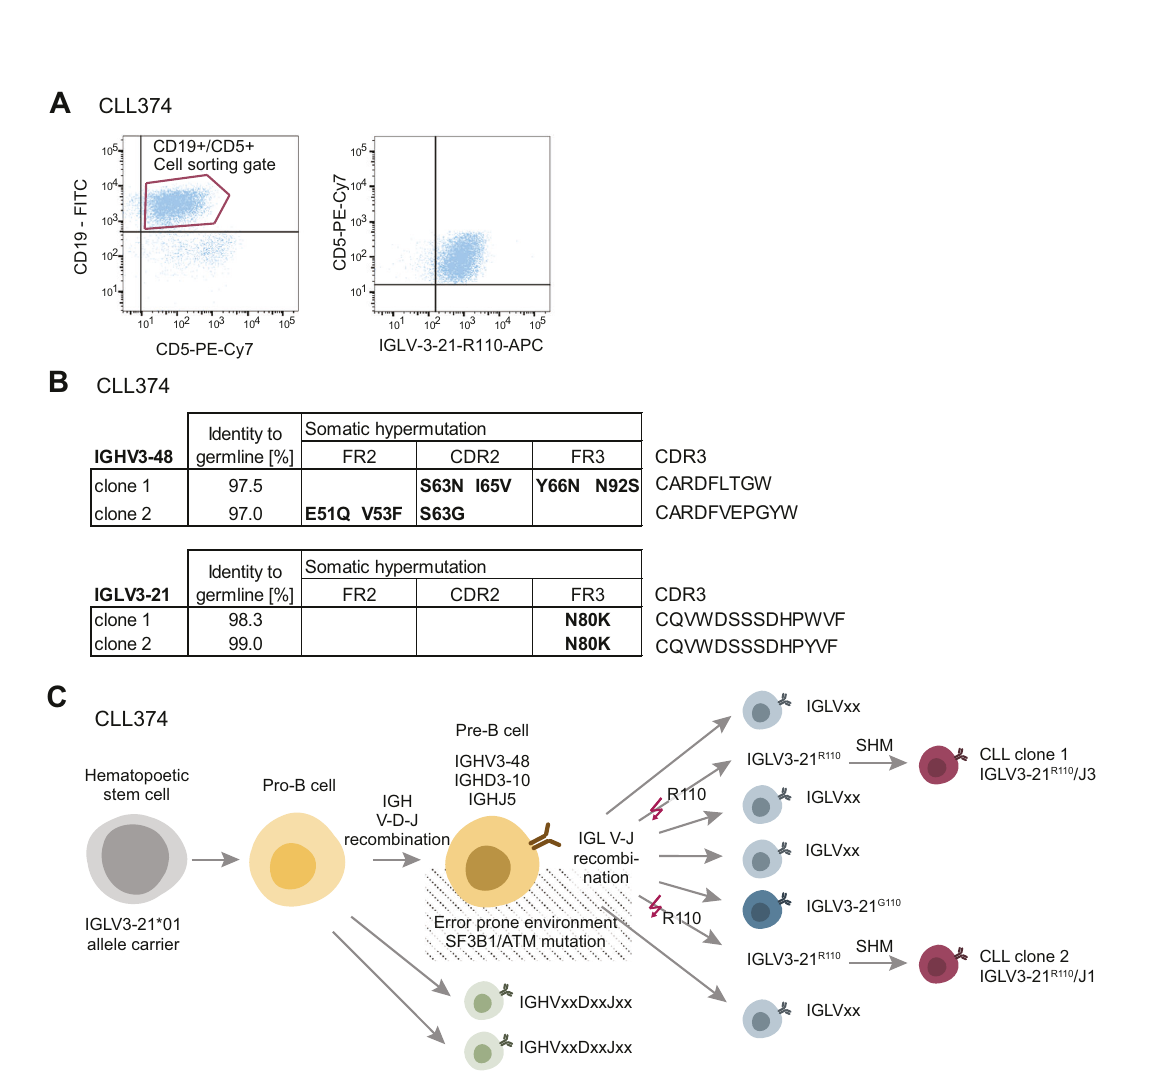
Fig. 2 Clonal evolution in patient CLL374. A Exemplary fl ow cytometric image of one CLL case positive for expressing IGLV3-21 R110 (CLL374). The images were created using FlowJo ™ Software (BD Biosciences). The CD19 + /CD5 + cell fraction of CLL374 was sorted and subjected to heavy and light chain NGS for con fi rmation of CLL clone sequences. B Sites of somatic hypermutation in IGHV and IGLV genes of clone 1 and 2 of CLL374 with discordant IGLV-J rearrangements. Clone 1 and 2 were found in bulk sequencing of genomic DNA isolated from PBMCs as well as in the CD5 + /CD19 + cell fraction sorted via FACS ( A ). C Schematic representation of clonal trajectories leading to different CLL subclones in patient the different clones constituting one tumor must have developed their major driver mutation — the R110 light chain residue — in a parallel evolutionary trajectory. This supports the pronounced functional importance of the IGLV3-21 R110 light chain as a tumor driver in this CLL subset. At the same time, this data suggest that although the mutational process is stochastic, genetic trajectories may be heavily constrained by convergence on key signaling pathways. In our setting, this highlights the robust evolutionary selection of BCR-BCR interaction and autonomous signaling.